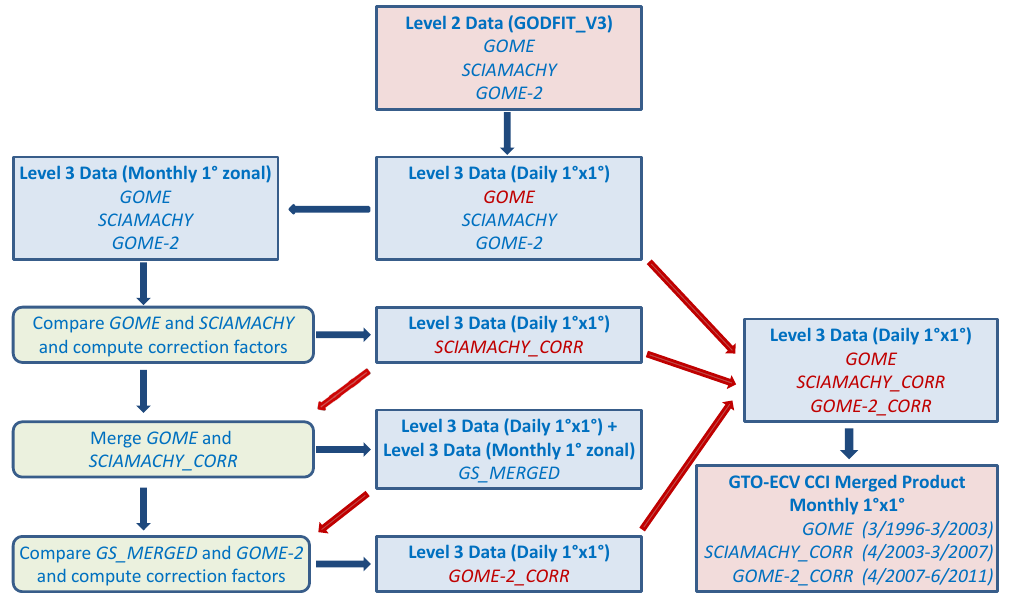
Figure 2. Flow chart of the GTO-ECV CCI level 3 algorithm and merging approach. Red-shaded boxes denote data records which are part of the official ESA Ozone CCI Climate Research Data Package (CRDP). Blue-shaded boxes denote intermediate data sets needed to create the merged final product, and green shading denotes the steps of the merging approach.